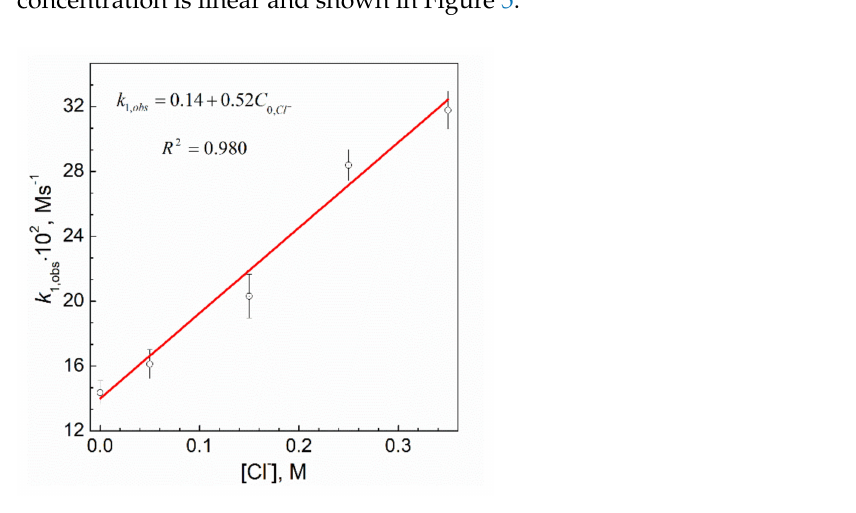
Figure 5. The influence of chloride ions addition on the observed rate constant for the reaction between platinum(IV) ions and sodium borohydride. Conditions: C 0,Pt(IV) = 0.05 mM, C 0,NaBH4 = 3.0 mM, T = 25.0 ± 0.1 ◦ C, pH = 12.9 ±